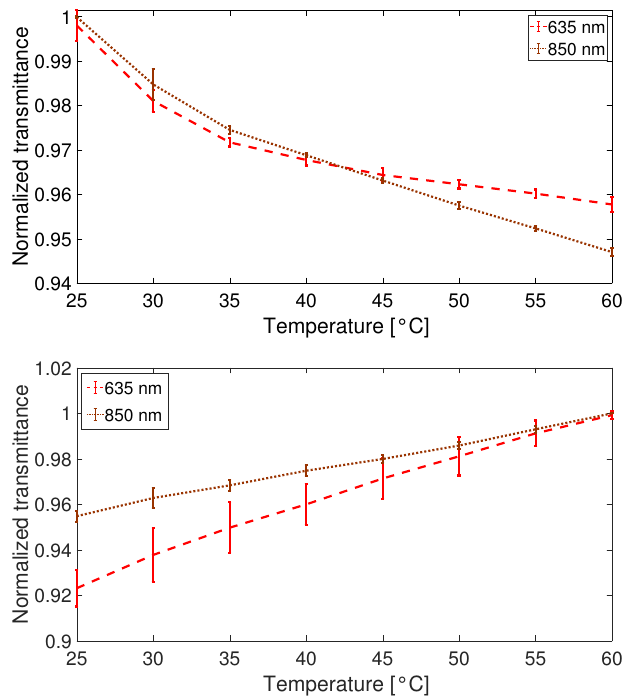
Figure 10. Experimental results from the thermal response of the SWW heated from room temperature to 60 °C. Depending on the external curing time, we were able to measure a decreasing ( top ) or increasing ( bottom ) optical transmission as the temperature